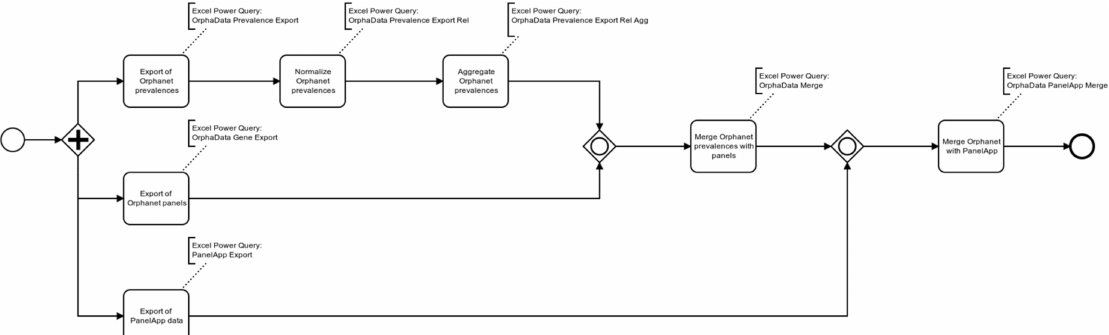
Figure 1. The multistep process of integration of the Orphadata and PanelApp resources into